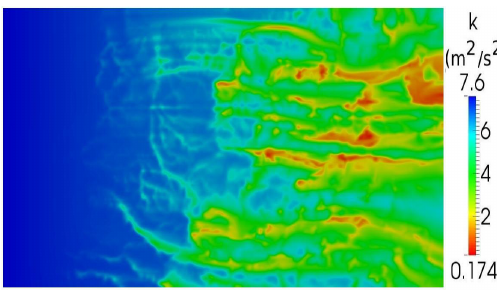
Figure 19. Turbulence kinetic energy distribution at 80